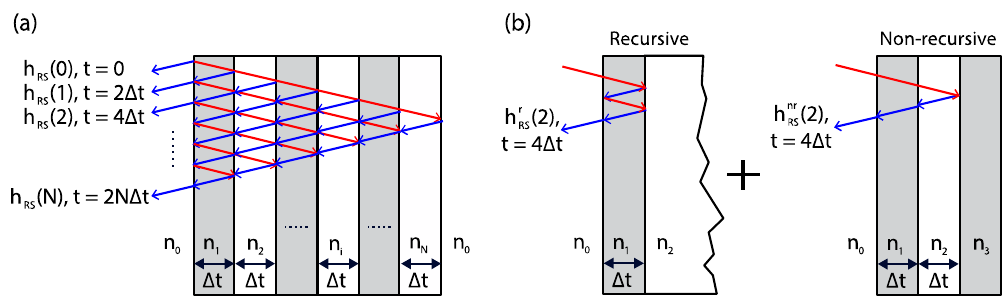
Figure 4. ( a ) Scheme of the division into layers of the FBG and the space-time paths contributing to the total sampled impulse response; ( b ) Decomposition of the space-time paths into the recursive path and the non-recursive path. The value of the refractive index of each layer is calculated from the non-recursive component of the impulse response in that layer, where the total impulse response and the non-recursive component are known.